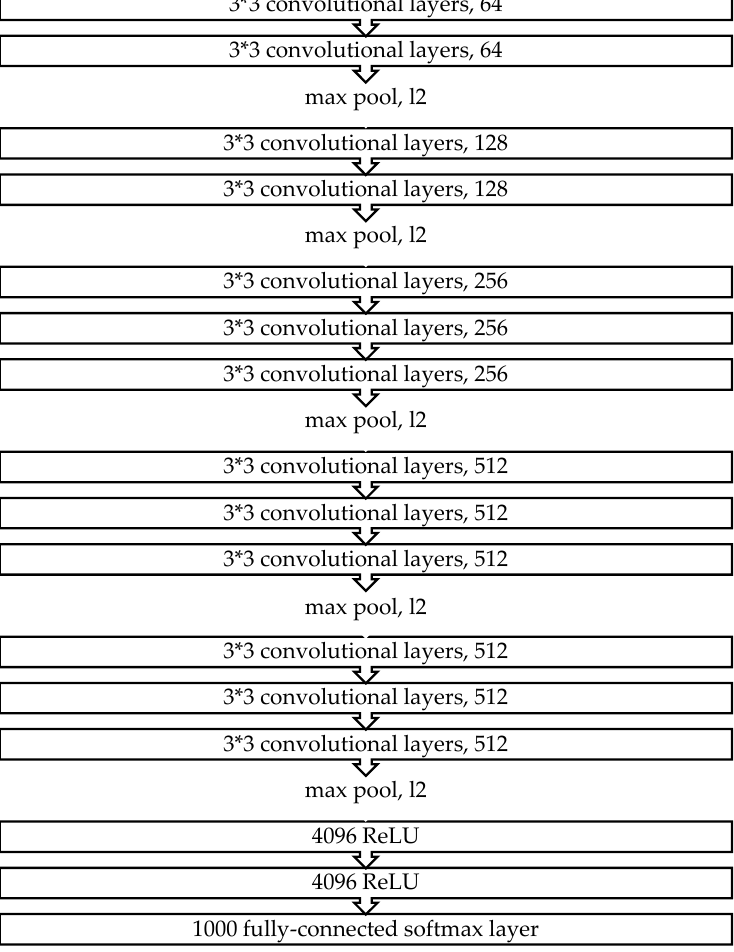
Figure 4. The VGG-16 architecture.